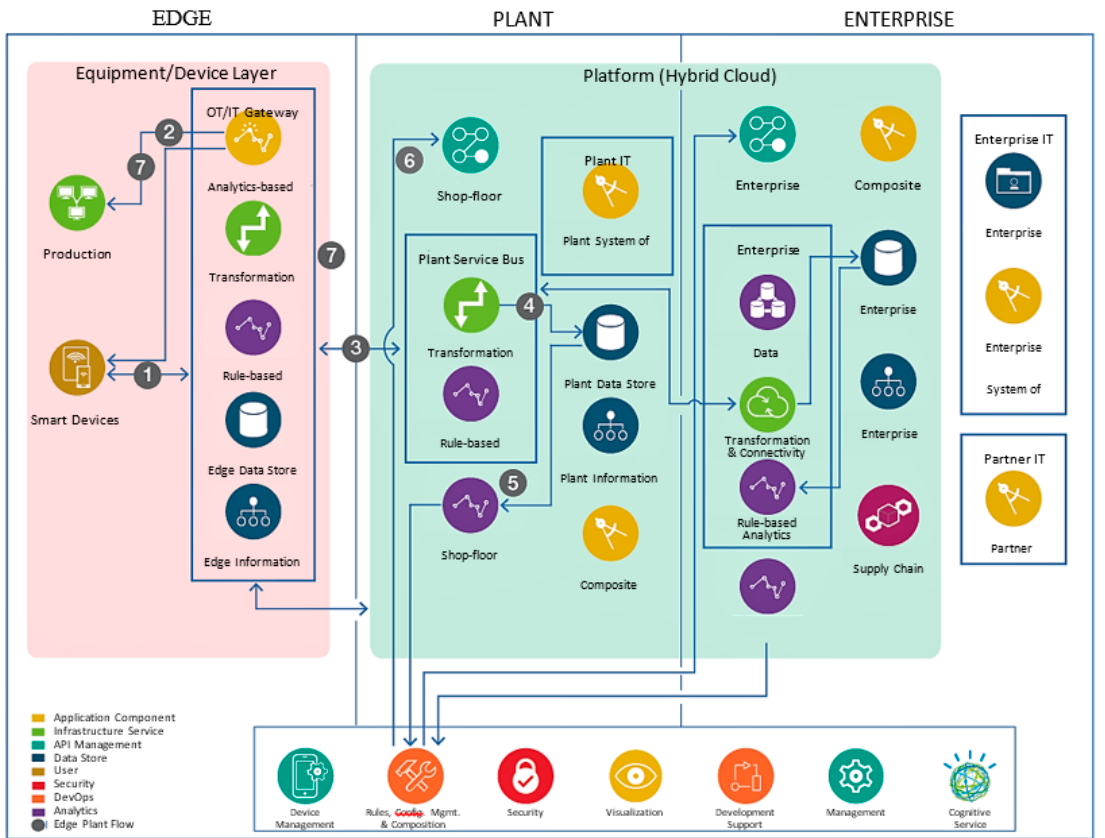
Figure 4. The IBM Industry 4.0 Architecture consisting of an Edge layer and Platform layer. (Reprint from Reference [49]).